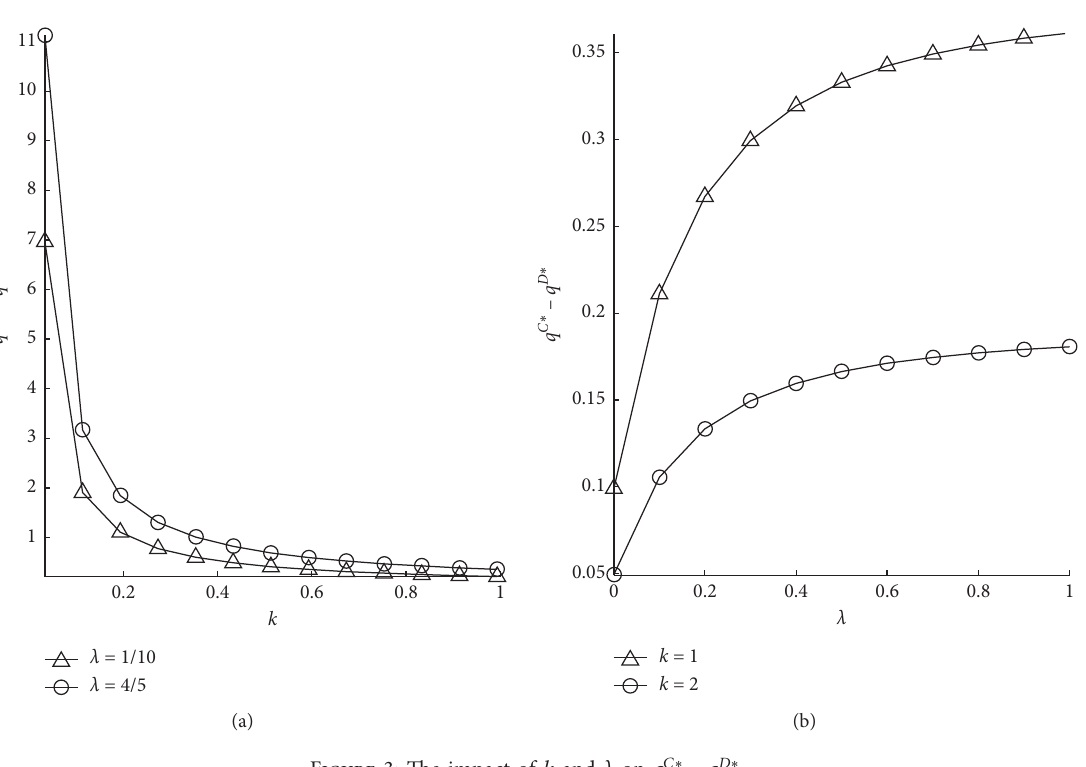
− p C ∗ ( i � 1 , 2 ) Gi Gi